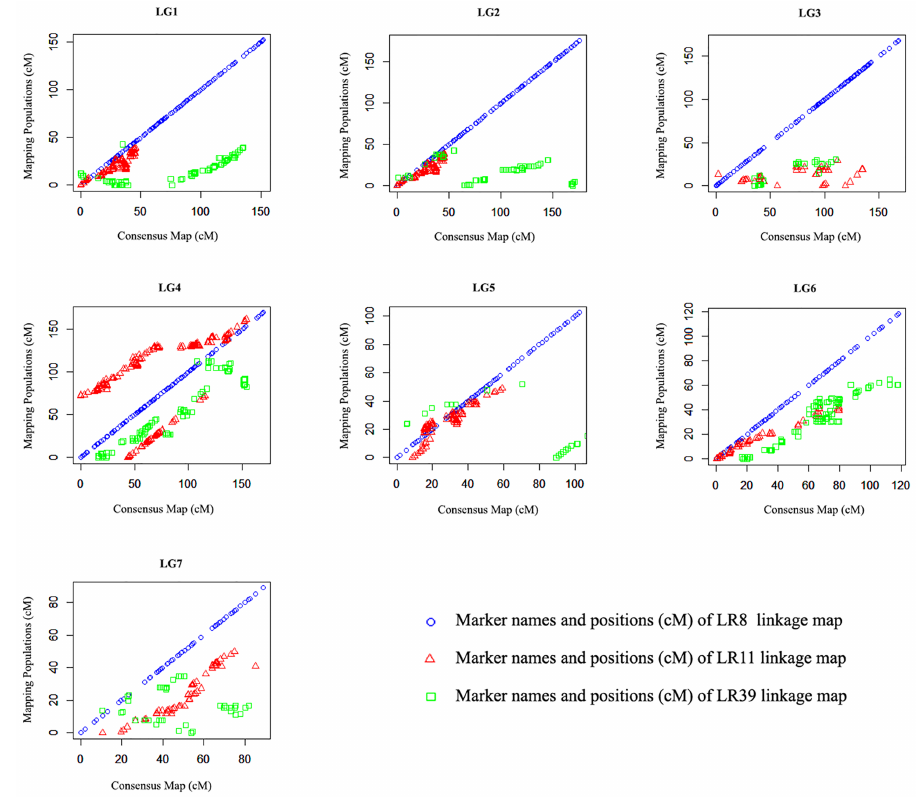
Fig 1. Comparison of marker locations in consensus map and component